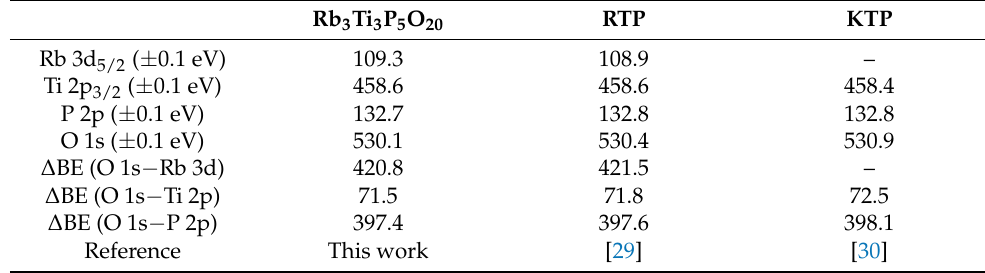
Table 2. Binding energy values (eV) of Rb 3 Ti 3 P 5 O 20 , RTP, and KTP crystals.